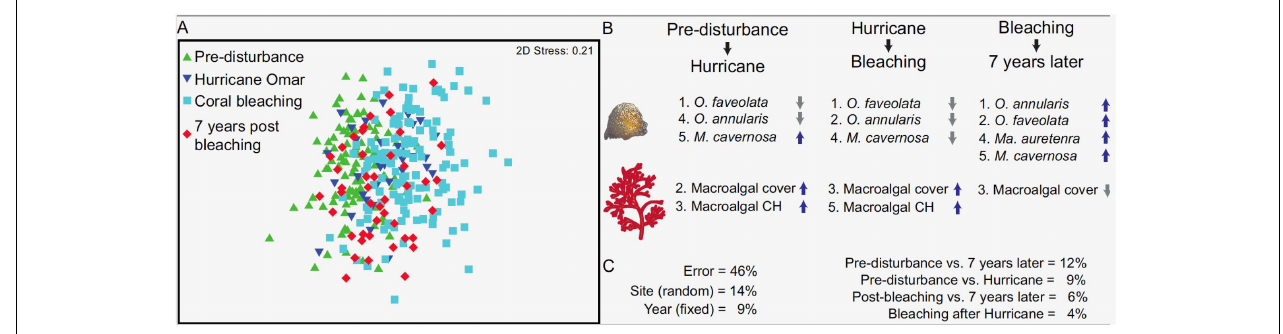
FIGURE 9 | Temporal changes in benthic community structure for the major periods of disturbance and recovery. Visualization is provided using a non-metric MDS (A) . The top five most important taxa characterizing benthic changes (B) are ordered in declining sequence (i.e., 1 being most important), and a breakdown of variance components is provided (C) for the total spatio-temporal variability in community structure, including the contrasts.